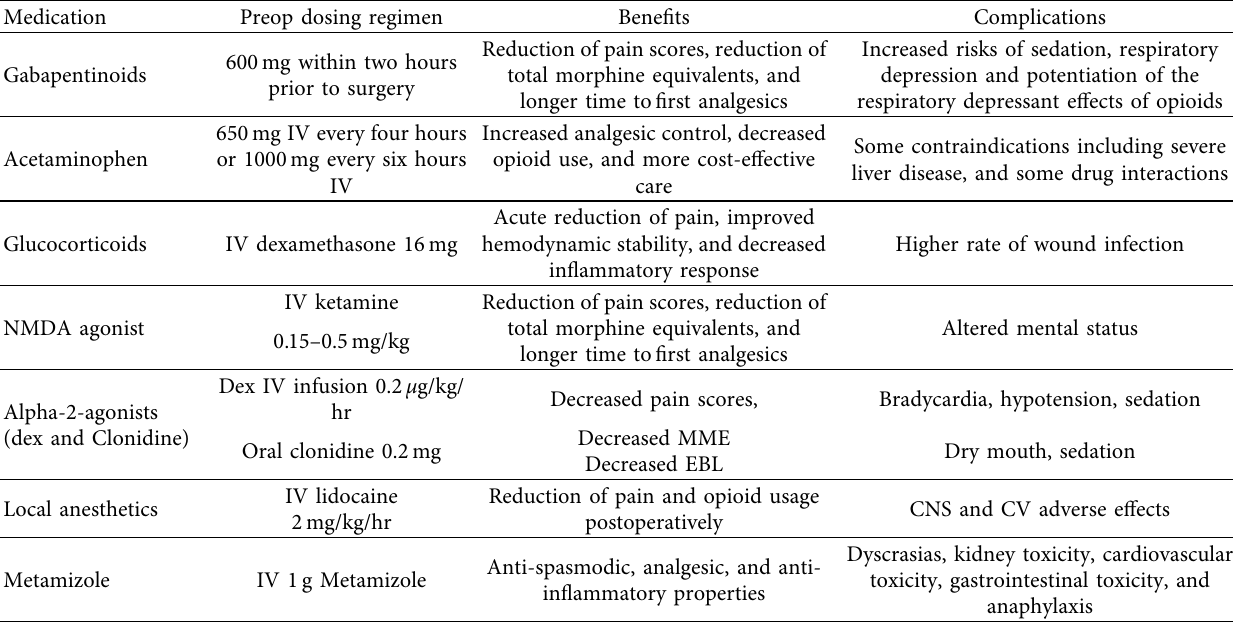
Table 1: Proposed preoperative non-opioid medications and dosing